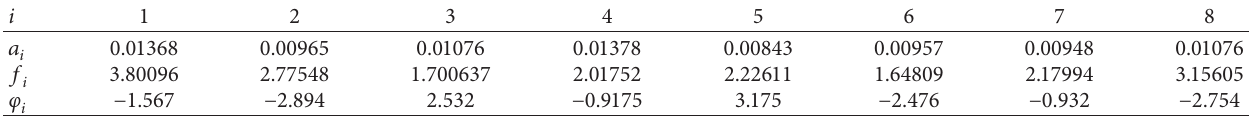
Table 1: Values of 24 fitting parameters in equation (1) in 0 ∼ 20s.